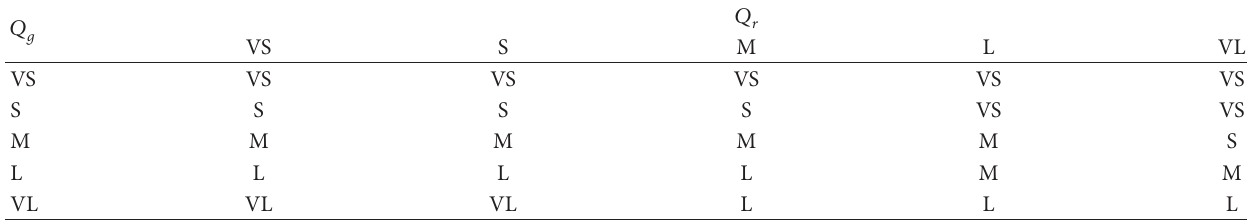
Table 2: The fuzzy rules of decision module for the delay time of current green light phase.